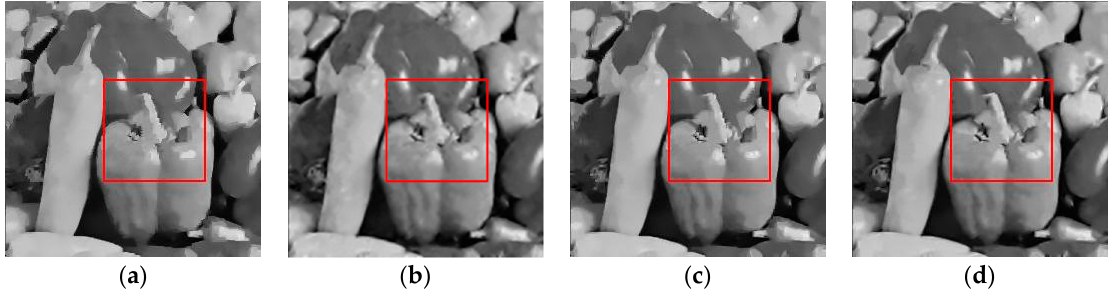
Table 6. The PSNR (dB)/SSIM results of various algorithms with different measurement rates. Image Algorithms